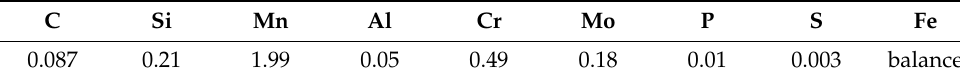
Table 1. Chemical composition of the studied steel in wt%.